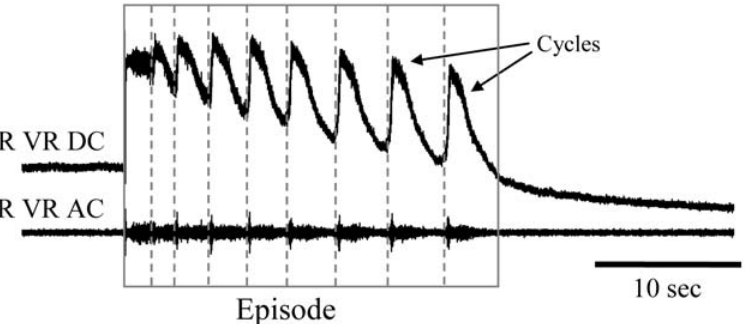
Figure 1. Structure of an episode of activity. Electrical activity recorded from a ventral root during a single episode of rhythmic activity. The duration of the complete episode is demarcated by the grey box. The onset of the individual cycles is defined by the dotted grey lines. 2 cycles are identified at the end of the episode. Data from an E8 embryo. R VR DC-Right Ventral Root DC recording; R VR AC-Right Ventral Root AC recording high pass filtered to show the discharge